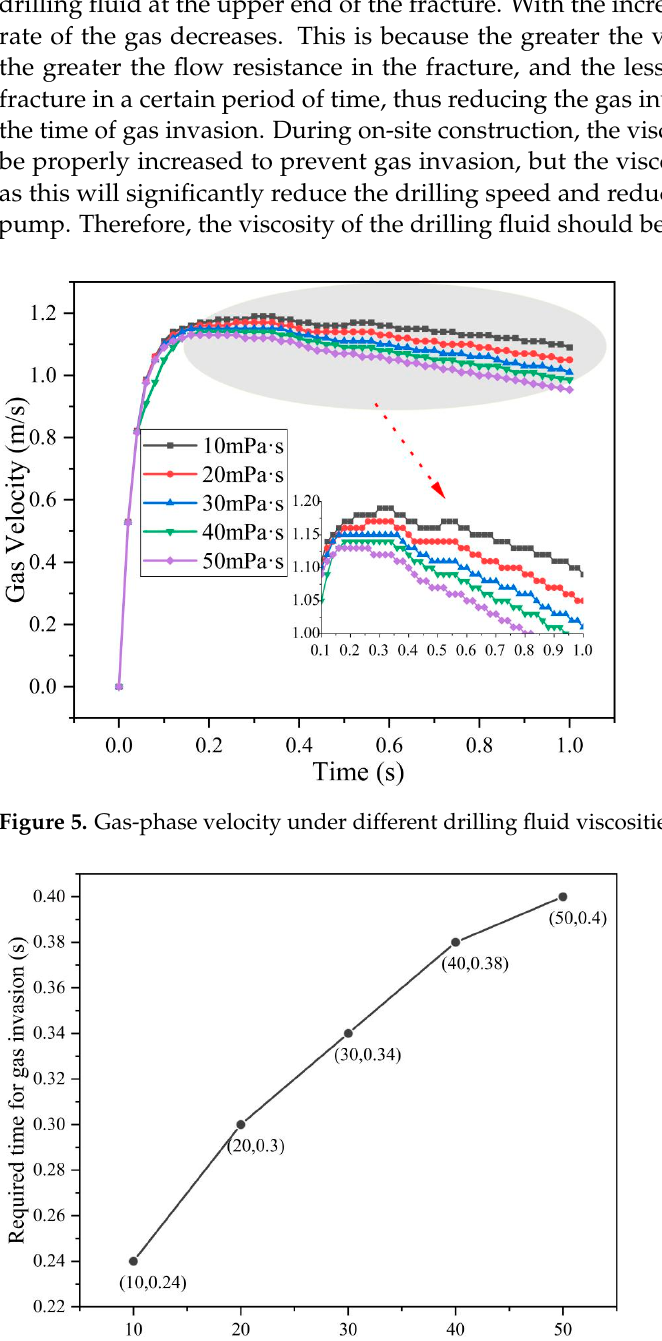
Figure 4. Pressure change of fracture and wellbore midpoint.